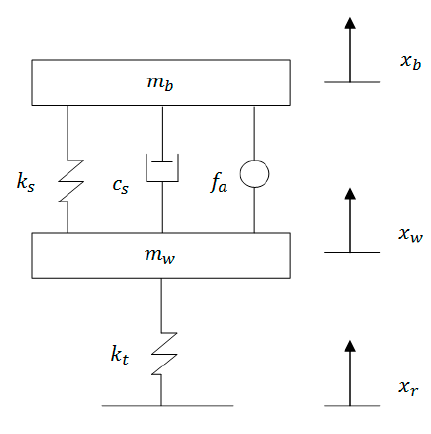
Figure 15. Quarter vehicle model. Table 1. Quarter vehicle suspension